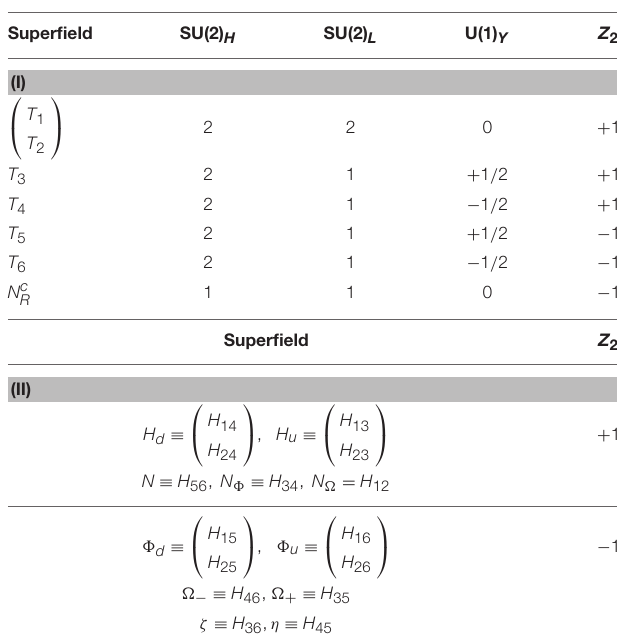
TABLE 1 | (I) The charge assignment of the SU(2) H doublets T i and the RHN N c R under the electroweak gauge group (SU(2) L content of the extended Higgs sector in the low energy effective theory below the scale 3 H